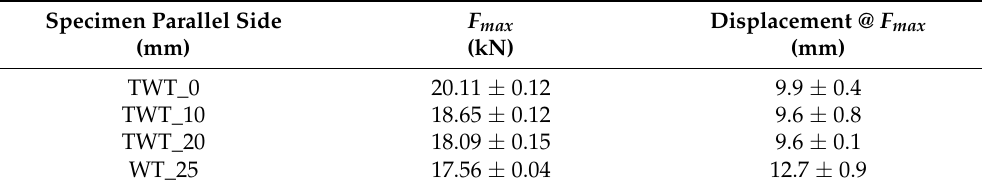
Table 6. Maximum load and corresponding displacement of Type B, 315 SDR 11 TWT, and WT specimens.